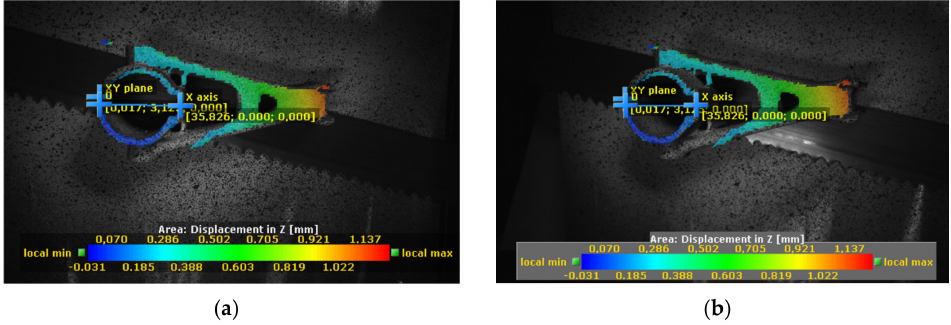
Figure 12. Maximum displacement on the left camera ( a ) and on the right camera ( b